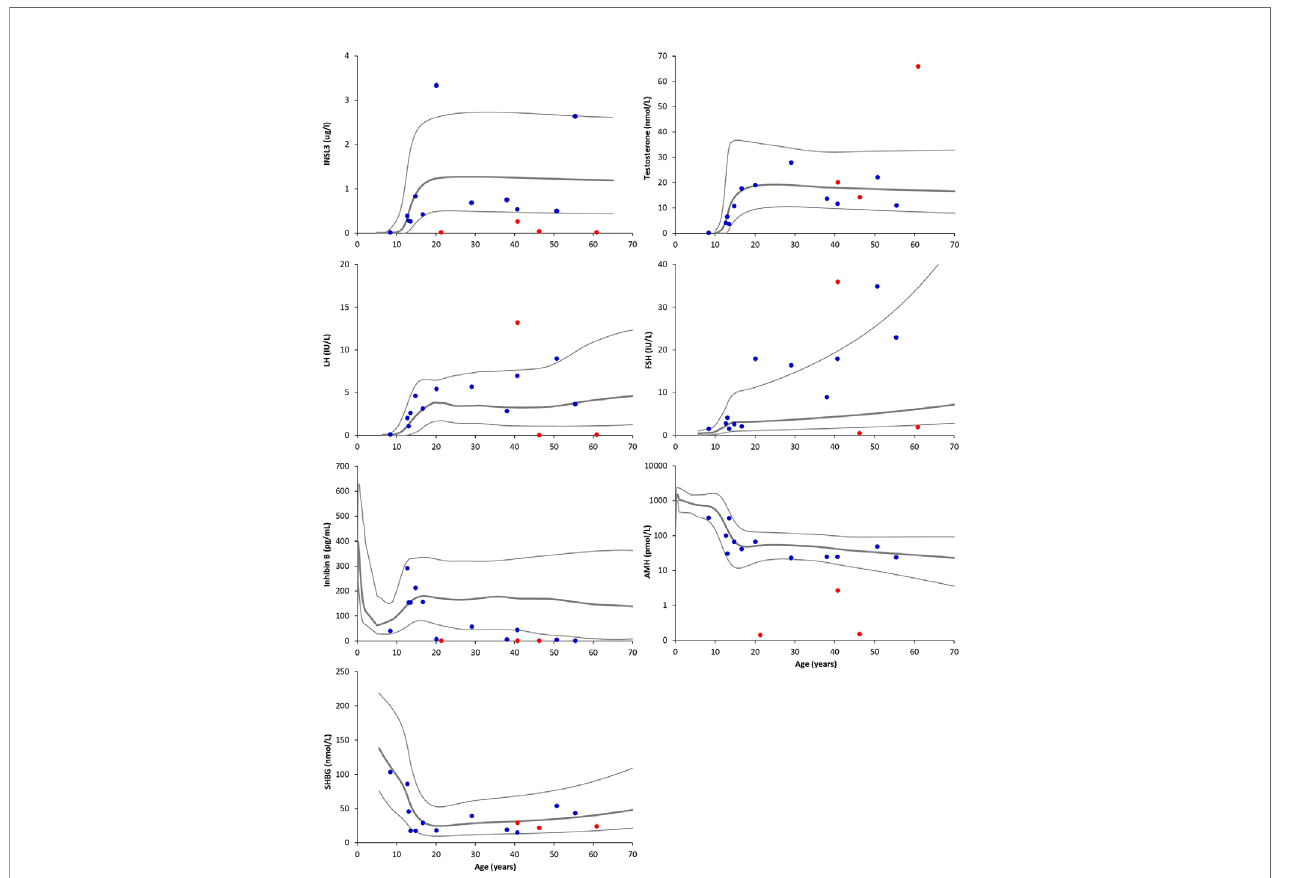
FIGURE 1 | Serum concentrations of insulin-like factor 3 (INSL3), testosterone, luteinizing hormone (LH), follicle-stimulating hormone (FSH), inhibin B, anti-Müllerian hormone (AMH, note: logarithmic Y axis), and sex hormone-binding globulin (SHBG) according to age in male patients with 45,X/46,XY mosaicism. Red dots indicate testosterone-treated patients, while blue dots indicate untreated patients. Grey lines indicate +2 SD, mean, and -2 SD of the respective reference ranges.